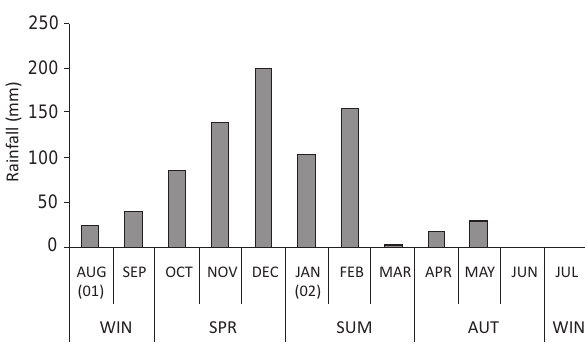
Figure 2. Monthly rainfall rates (mm) in Rio de Janeiro, during the study period. Source: Instituto Nacional de Meteorologia. (WIN) Winter, (SPR) spring, (SUM) summer, (AUT) autumn.